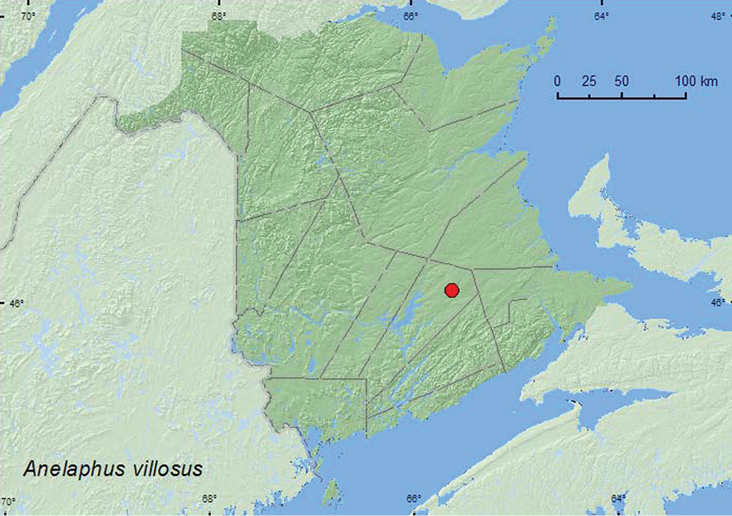
 Collection localities in New Brunswick, Canada of Anelaphus villosus.